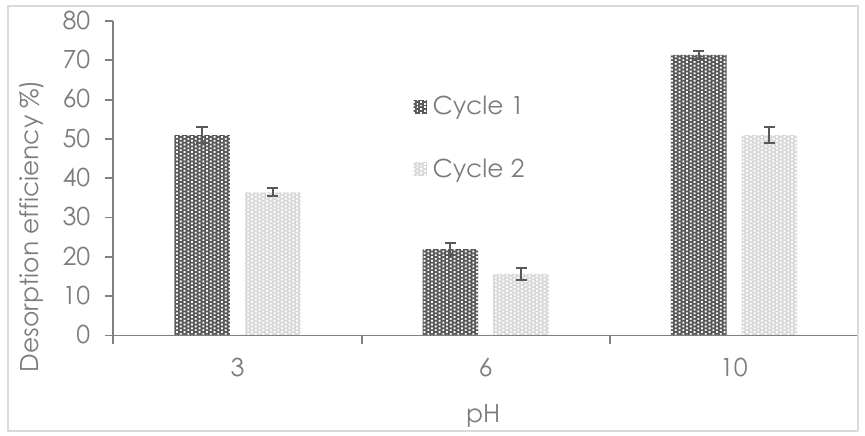
Figure 8. Phosphate adsorption-desorption profile as a function of pH at two cycles.